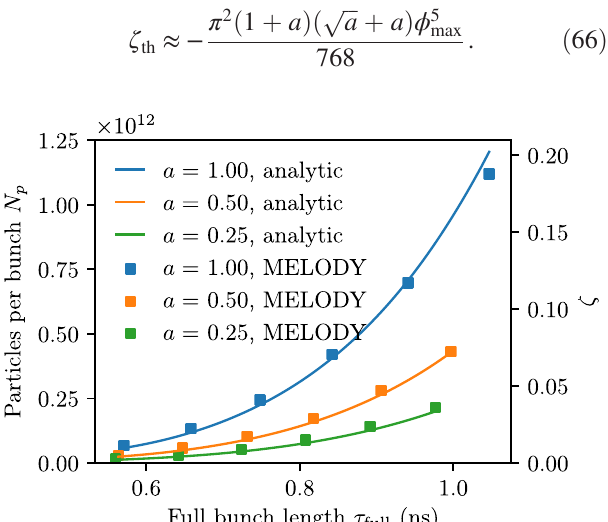
FIG. 16. Residual oscillation amplitude (colors and black contour lines) after a kick of Δ ϕ ¼ 1 deg above the LLD threshold as a function of bunch intensity and the scaled bunch length for a broadband impedance with Im Z=k ¼ 0 . 076 Ω , FIG. 17. The LLD intensity threshold as a function of the full 5 GHz (the estimated cutoff frequency of the Q ¼ 1 , and f bunch length for the inductive impedance Im Z=k ¼ 0 . 07 Ω r ¼ ( η > 0 ) and the special particle distribution function (63) calcu- LHC beam pipe); μ ¼ 2 , V 0 ¼ 10 MV. The parameters of LHC lated for different parameters a using MELODY (squares) and bunches with LLD observed in measurements [7] are shown by a red box. analytic expression (66) (color lines) for V 0 ¼ 6